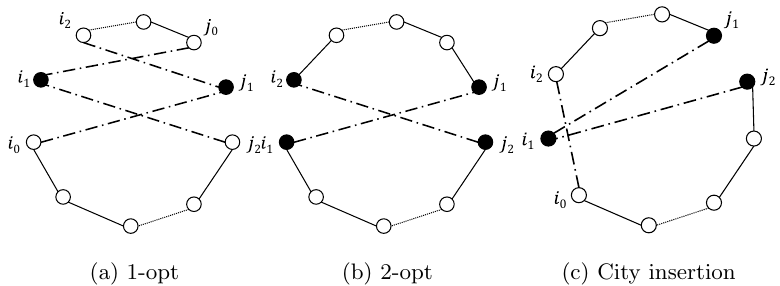
Figure 4. Illustration of neighborhood